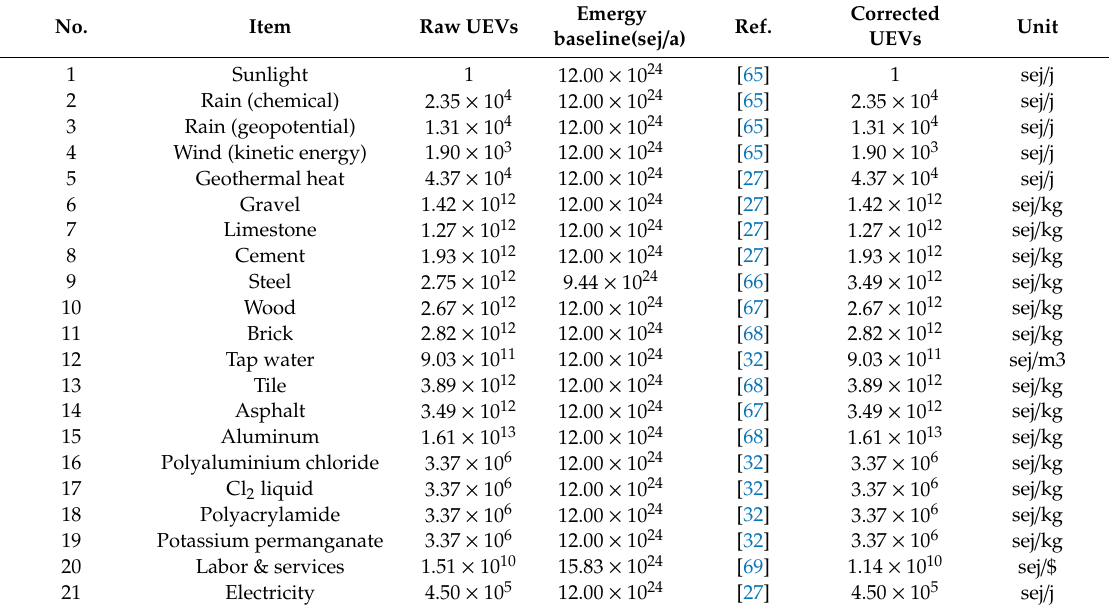
Table 9. Unit emergy values (UEVs) correction based on 12.00 × 10 24 sej / year